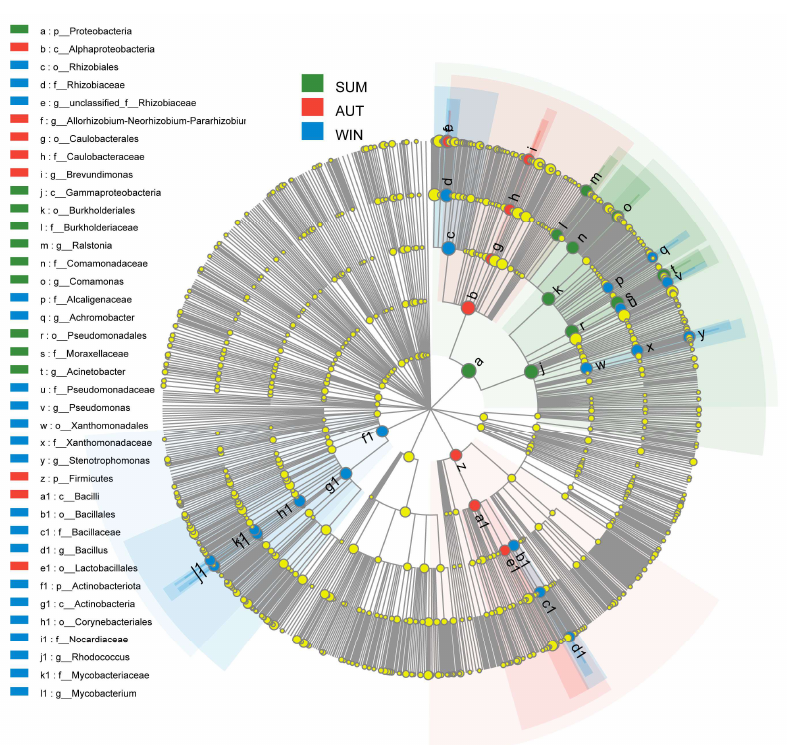
Figure 8. LEfSe analysis indicates the distinct taxonomic units of bacteria in various seasons. Differ- ently colored areas represent distinct components (red for autumn, green for summer, and blue for winter), and the diameter of each circle is proportional to the relative abundance of that taxon. The inner to outer circles correspond to the phylum to genus hierarchy. SUM: summer; AUT: autumn; WIN: winter.